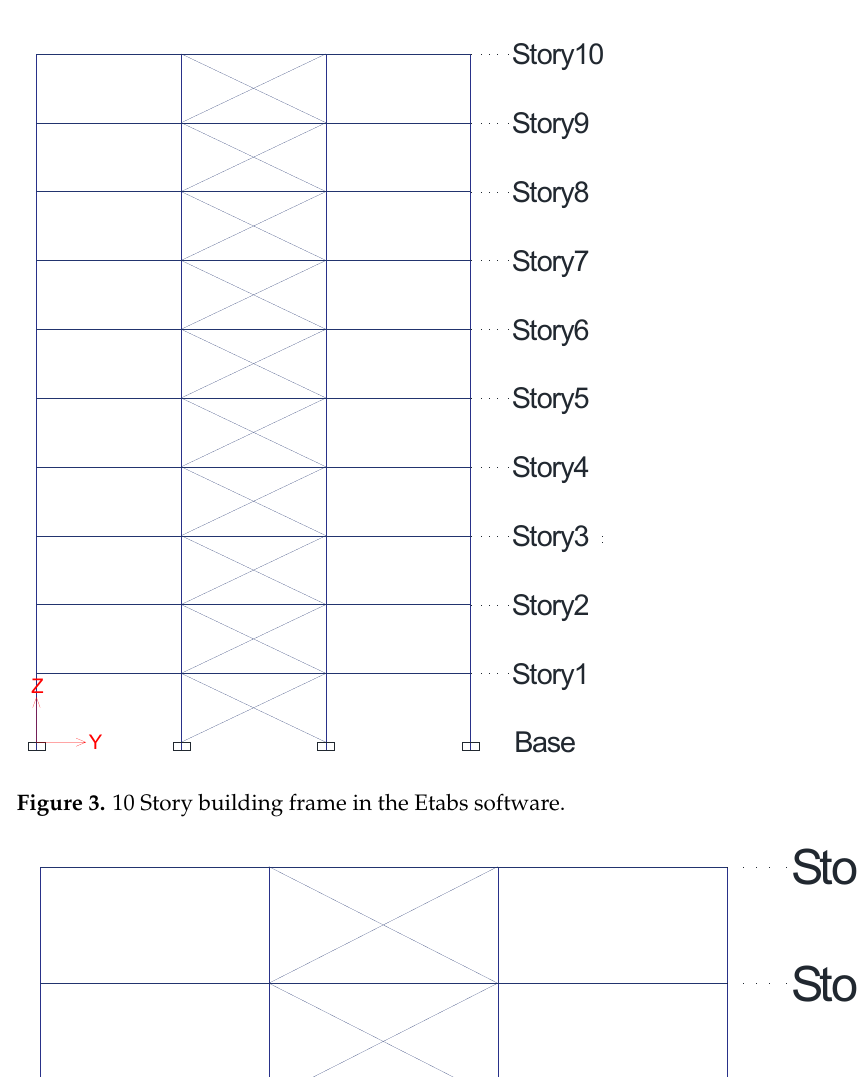
Figure 4. 3 Story building frame in the Etabs software.